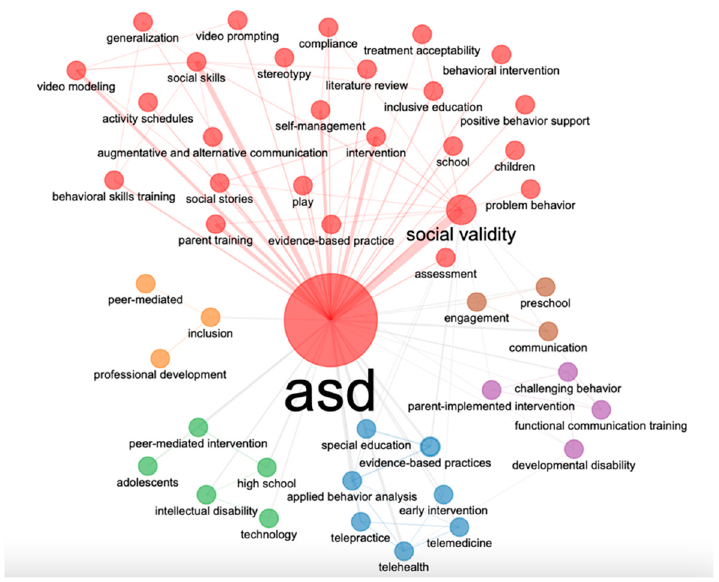
Figure 6. Co-word networks.